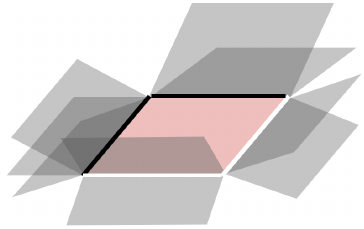
Figure 2 . Opposite internal edges of a Fermi have opposite colors. This translates in the toric condition of the